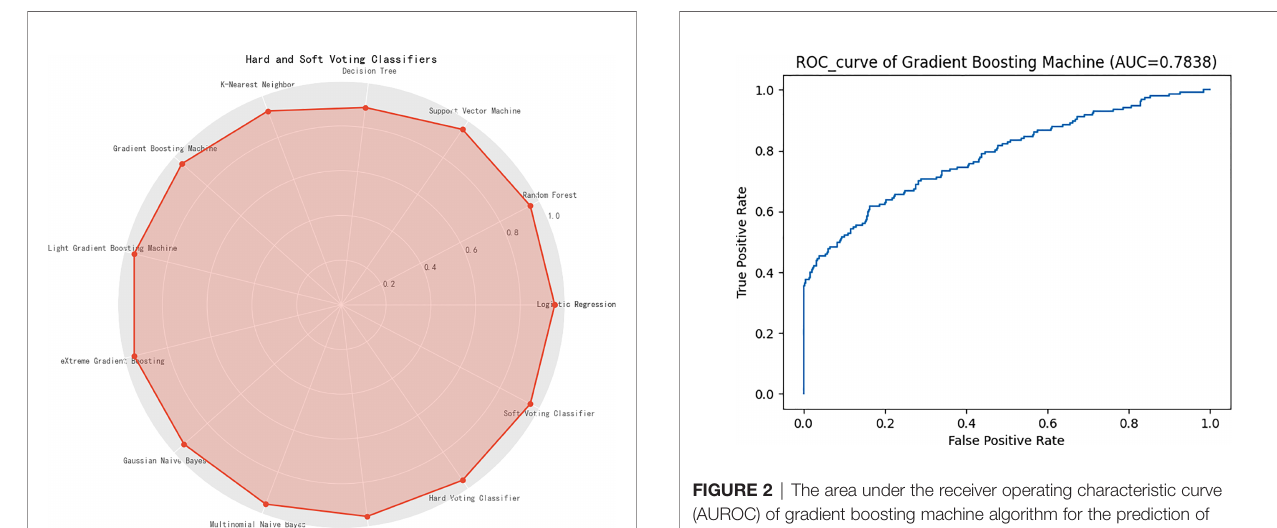
TABLE 2 | The prediction performance of 13 machine learning algorithms from accuracy, precision, recall, F1 score and AUROC aspects for precocious puberty. Algorithms Accuracy Precision Recall F1 score AUROC Logistic regression